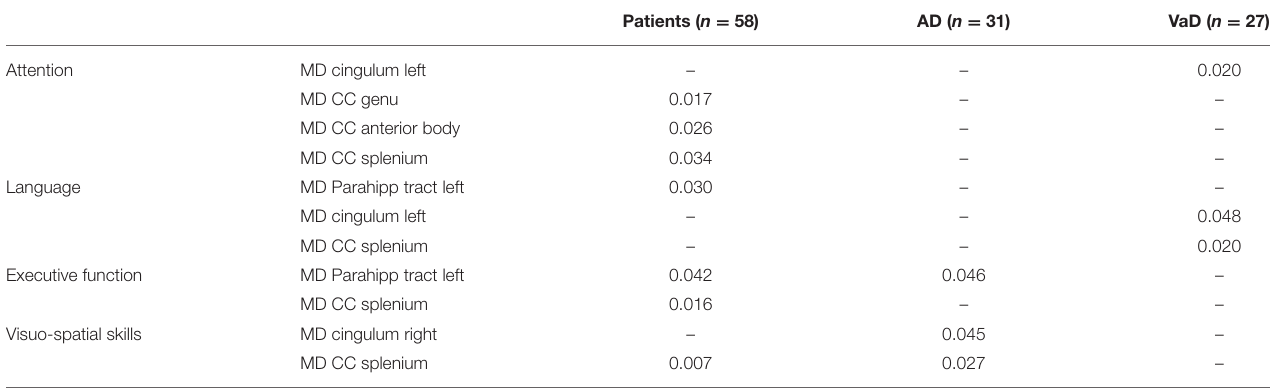
TABLE 8 | Neuropsychological correlations with DTI derived